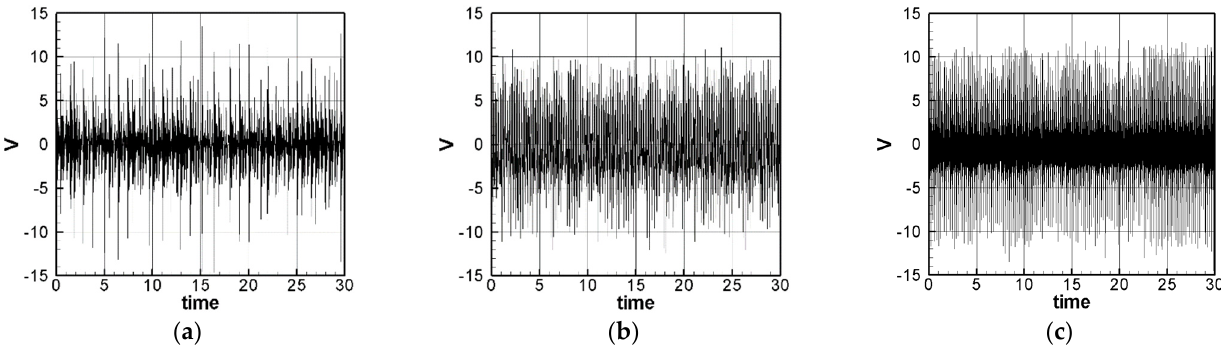
Figure 18. DES system experimental voltage output (with dimension (volt)). ( a ) 1st mode, ( b ) 2nd mode, and ( c ) 3rd mode.